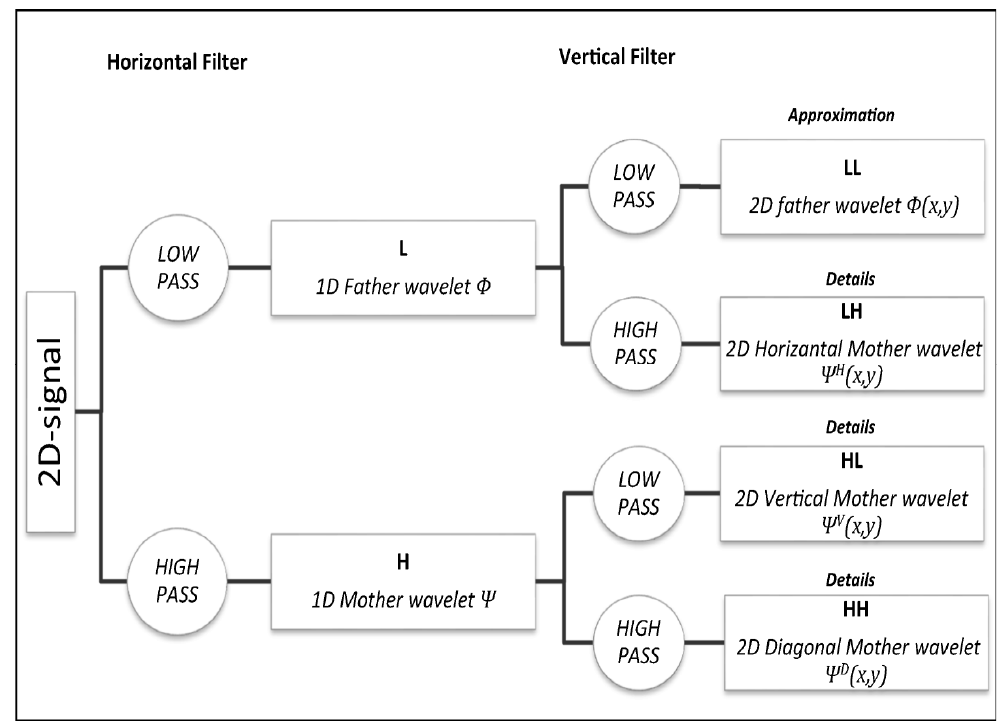
Figure 5. Decomposition process. Figure 5.